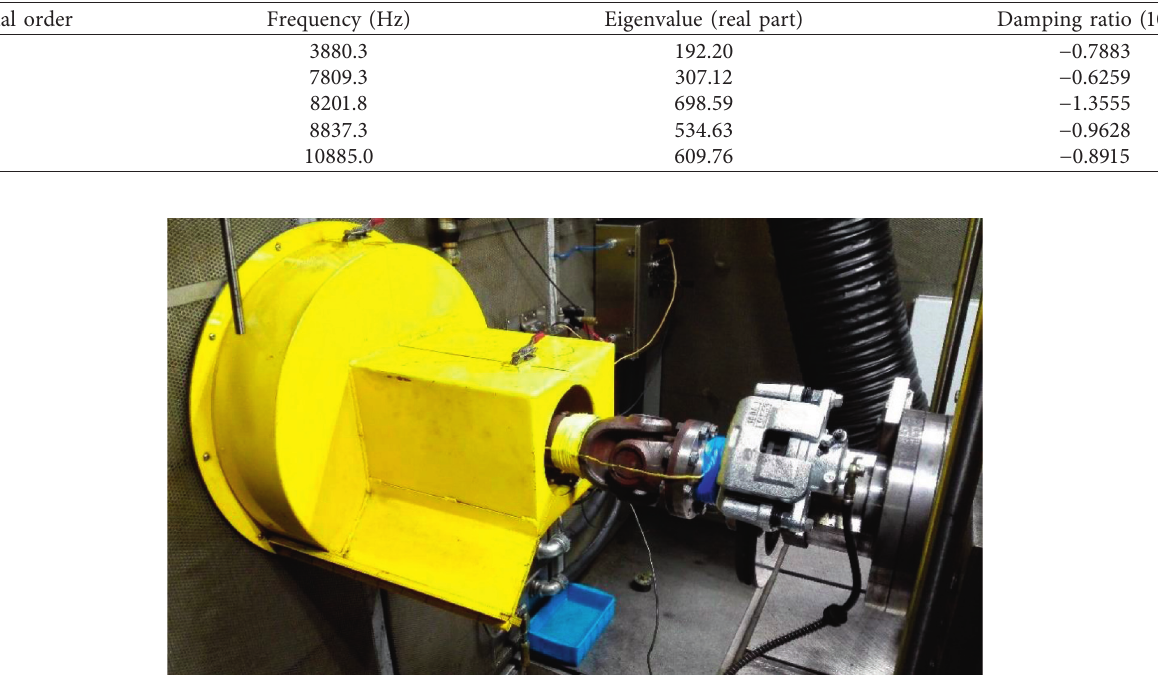
Figure 3: Brake assembly and dynamometer.